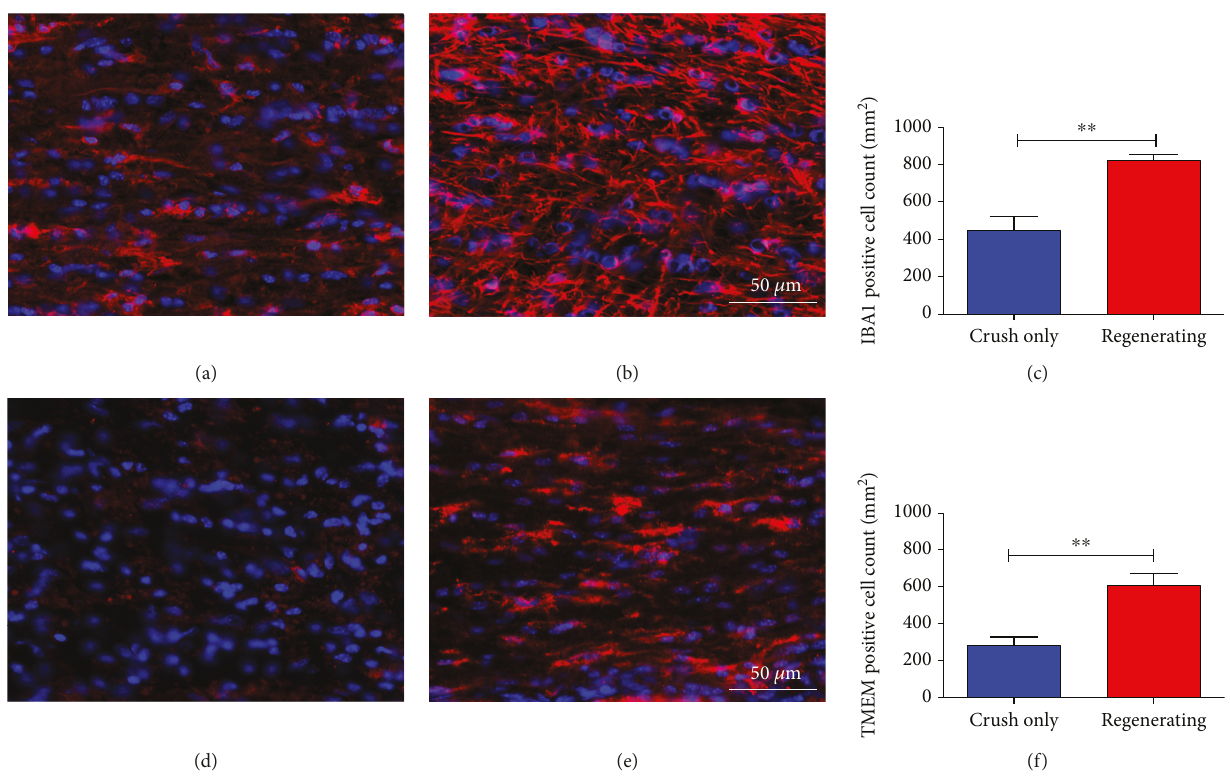
Figure 3: Macrophage/microglia within the optic nerve. (a – c) Iba-1 (red) and nuclear staining (blue) two weeks after injury. (a) Optic nerve from the Crush-only group showing a reduced Iba-1 staining; (b and c) optic nerve and quantitative analysis exhibiting intense levels of Iba-1 in the Regenerating group. (d – f) Tmem (red) and nuclear (blue) staining two weeks after injury. (d) Optic nerve from the Crush-only group. (e and f) Optic nerve image and quantitative analysis presenting higher levels of Tmem density in the Regenerating group. N = 5 per group. Scale bars: (a, b, d, e) 50 μ m. Error bars in (c) and (f) show SEM. ∗∗ P < 0 01